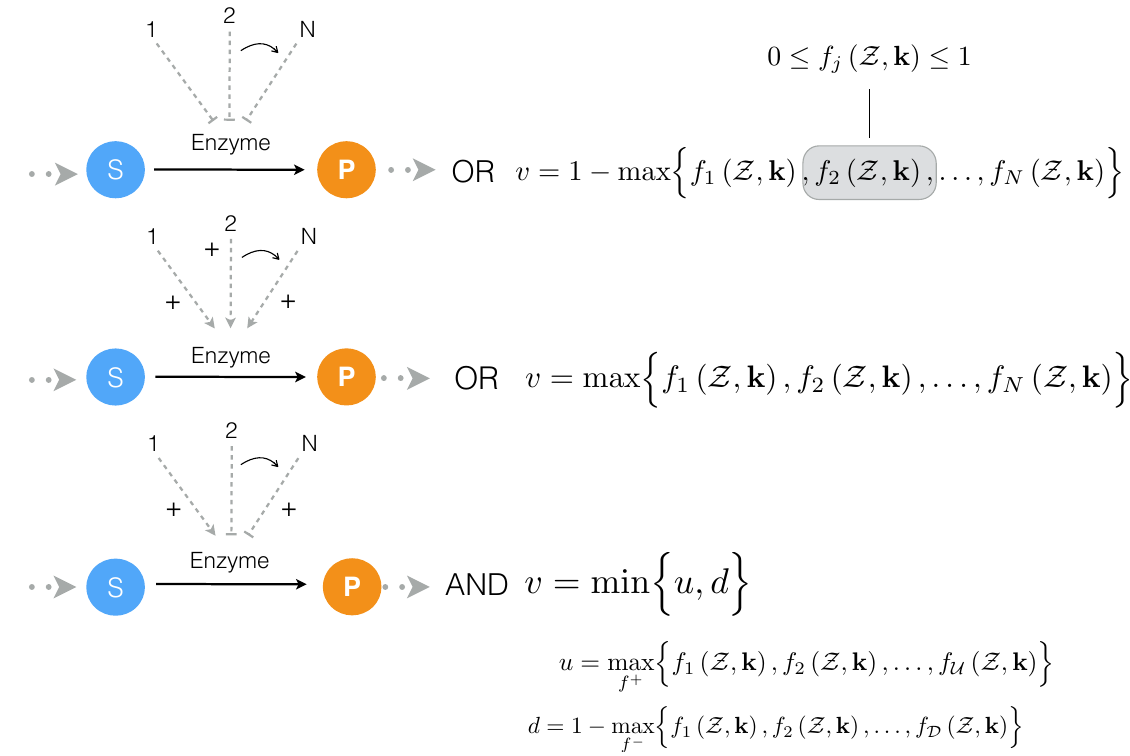
Figure 2. Schematic of rule-based allosteric enzyme activity control laws. Traditional enzyme kinetic expressions, e.g., Michaelis-Menten or multiple saturation kinetics, are multiplied by an enzyme activity control variable 0